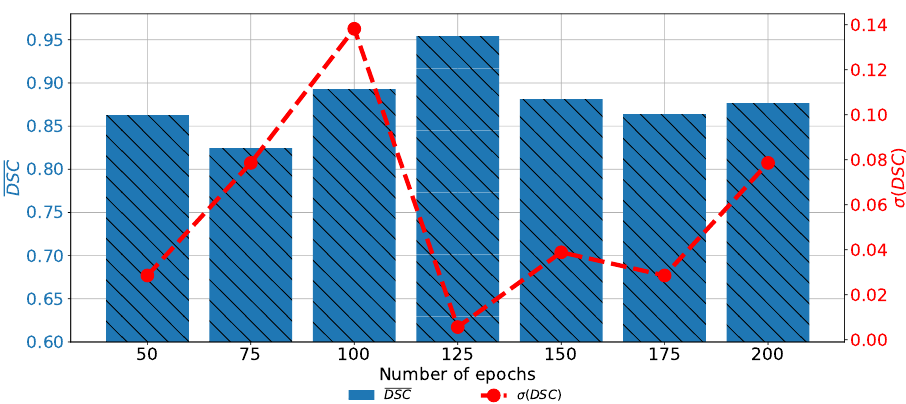
Figure 12. The change of DCS and σ ( DSC ) through a number of epochs achieved with pre-trained ResNet101 as U-net backbone for the semantic segmentation of urinary bladder cancer masses from CT images in frontal plane.